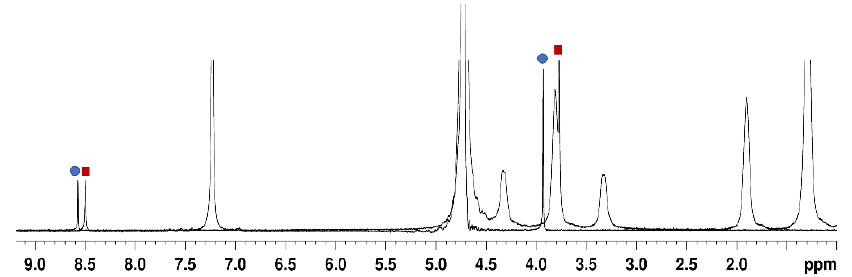
Figure 5. Overlapped 1 H NMR spectra (D 2 O, phosphate buffer, 297 K) of TMZ alone (5.3 mM, blue circles) and TMZ complexed with 3.5 mM SC4OC6 (5.3 mM, red squares).